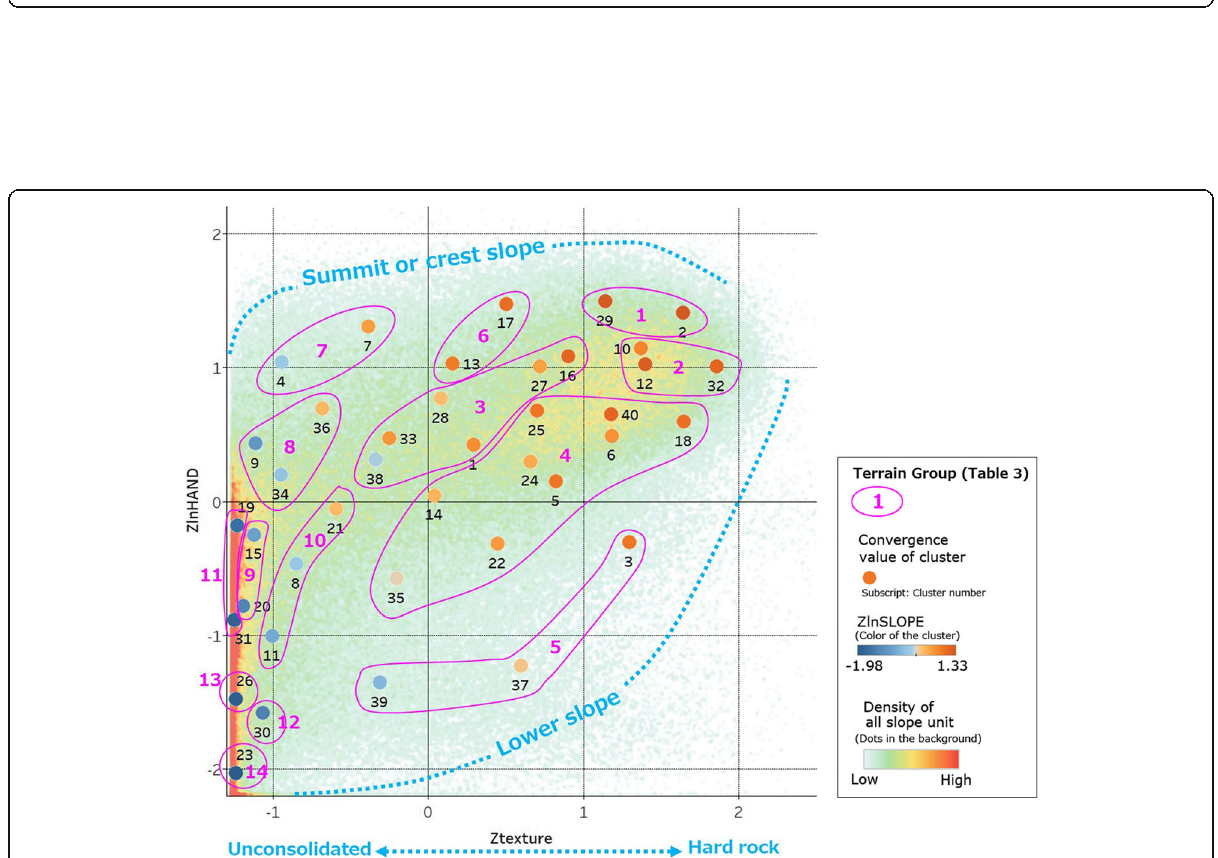
Fig. 10 Cross-tabulation of 40 clusters with major landslides showing breakdowns. As locations of major landslides, we used 371,732 center points of landslide masses in data 4